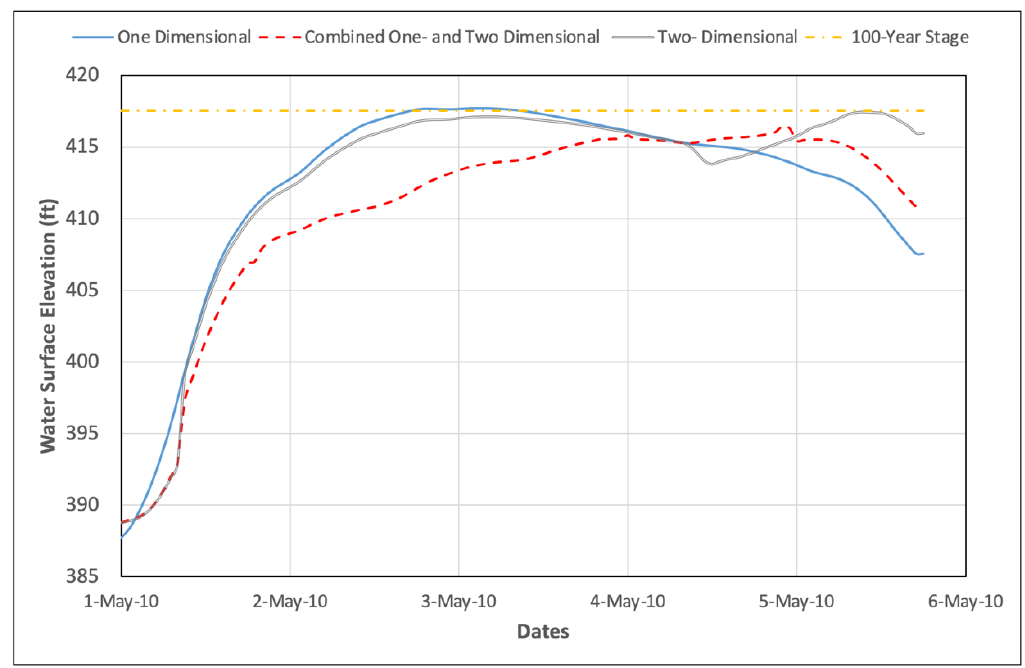
Figure 13. Comparison of 100-year and optimized water surface elevations for the May 2010 flood event at Nashville for three scenarios of unsteady flow modeling.